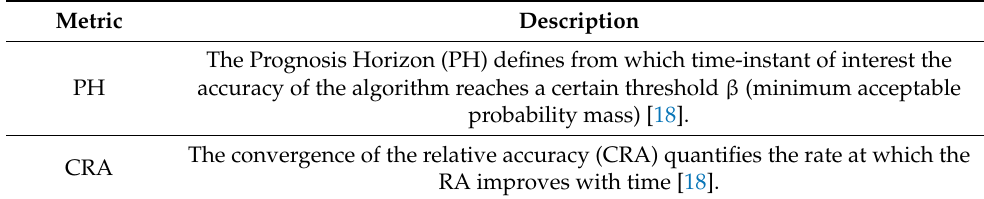
Table 2. Set of metrics that quantifies the timeliness.